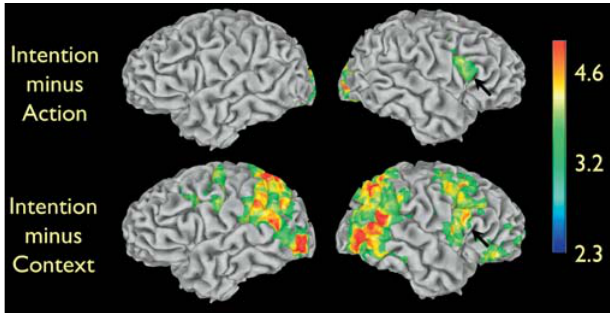
Figure 3. Signal Increases for Intention minus Action and Intention minus Context Threshold of Z = 2.3 at voxel level and a cluster level corrected for the whole brain at p , 0.05. The black arrow indicates the only area showing signal increase in both comparisons. The area is located in the dorsal sector of pars opercularis, where mirror activity has been repeatedly observed [10,11,12,13,14,15,16,17,18,19,20,27]. See Tables S1 and S2 for coordinates of local maxima. DOI: